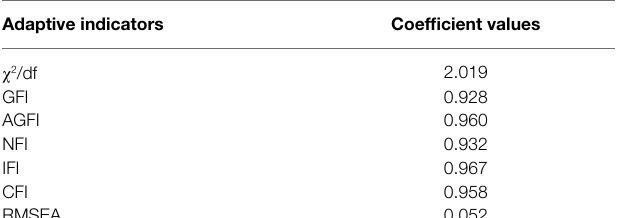
TABLE 5 | Fitting index of significance